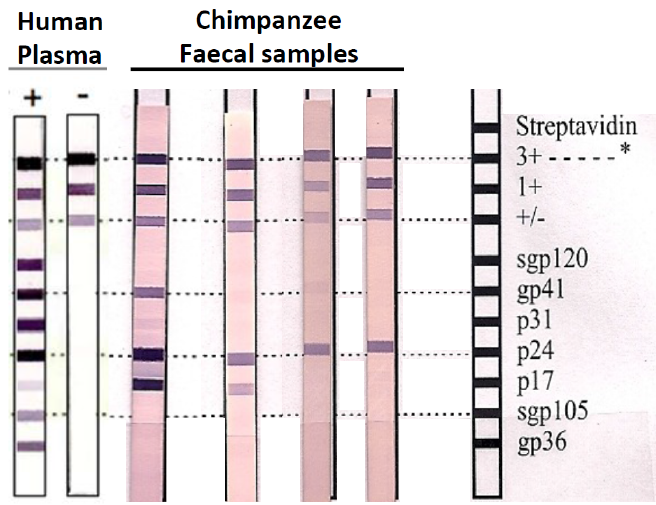
Figure 2. SIV antibody positive profiles. Example of HIV-1/HIV-2 cross-reactive antibodies profile in chimpanzee faecal samples using a line immunoassay (INNO-LIA HIV Confirmation, Innogenetics, Ghent, Belgium). Varying patterns of reactivity to HIV peptides and proteins (gp41, p24, p31 and p17) are shown. Plasma samples from HIV-1/HIV-2-negative and -positive persons are shown as controls on the left. The 3+, 1+ and +/ − bands at the top of all test strips control for sample addition (presence of plasma immunoglobulin) and test performance (binding of secondary antibody).